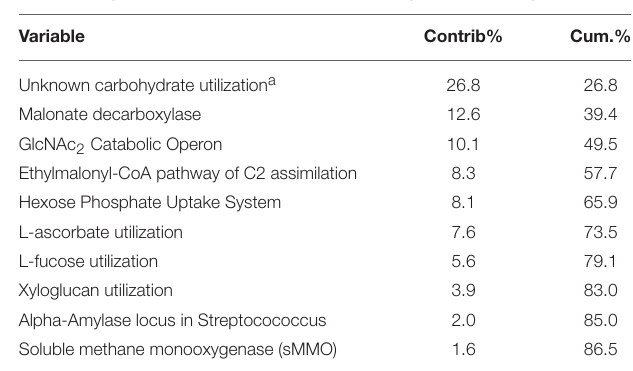
TABLE 2 | Contribution of gene pathways to compositional dissimilarity of the Carbohydrates classification as indicated by SIMPER